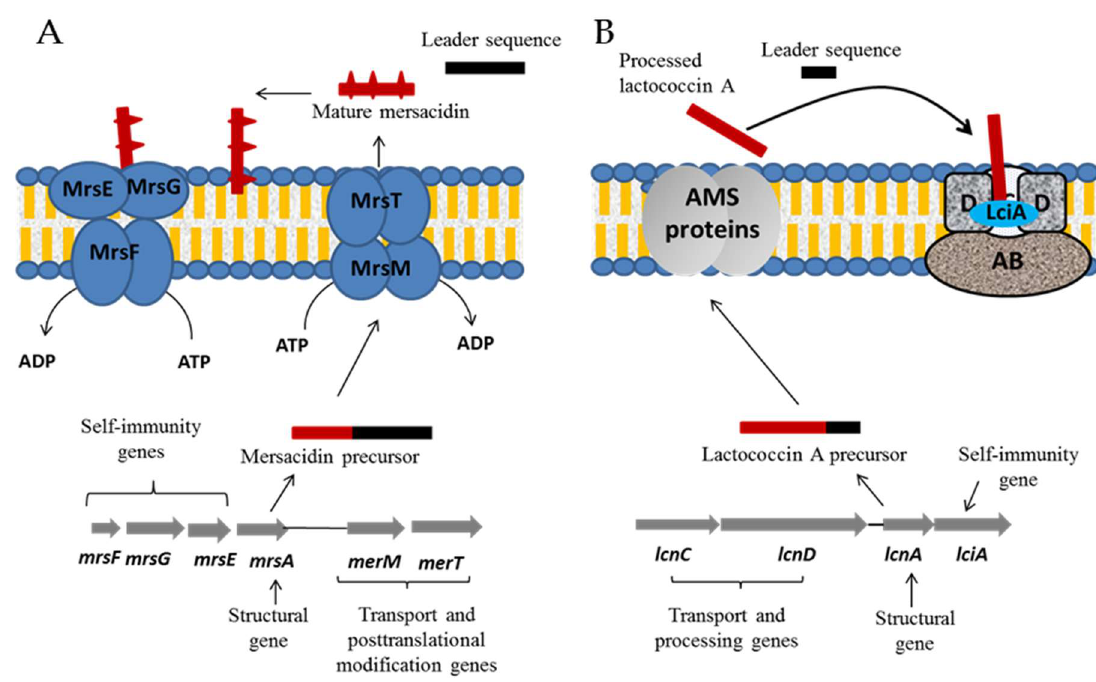
Figure 8. Self- immunity and transport mechanisms of mersacidin ( A ) and lactoccocin A ( B ) that target lipid II and Man-PTS, respectively. Proteins employed for self-immunity and transport of these bacteriocins are distinct and encoded by di ff erent genetic elements, as presented.